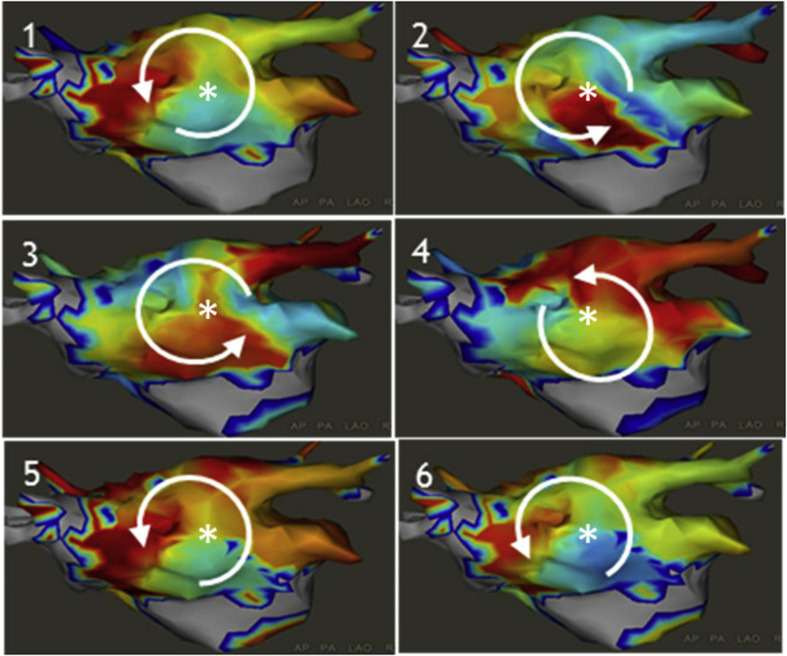
Example of CARTOFINDER showing a counter clockwise rotational repetitive activation pattern through time (panels 1–6). Daoud et al. (2017) reprinted with permission.